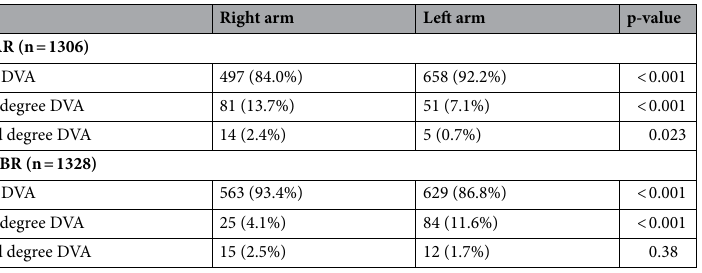
Table 2. Prevalence of difficult vascular anatomy (DVA) at the primary FAA site. In 1328 procedures successful sheath insertion allowed for adequate assessment of DVA in the radial-ulnar-brachial region (RUBR). In 1306 procedures, DVA could be adequately assessed in the subclavian-innominate-aortic region